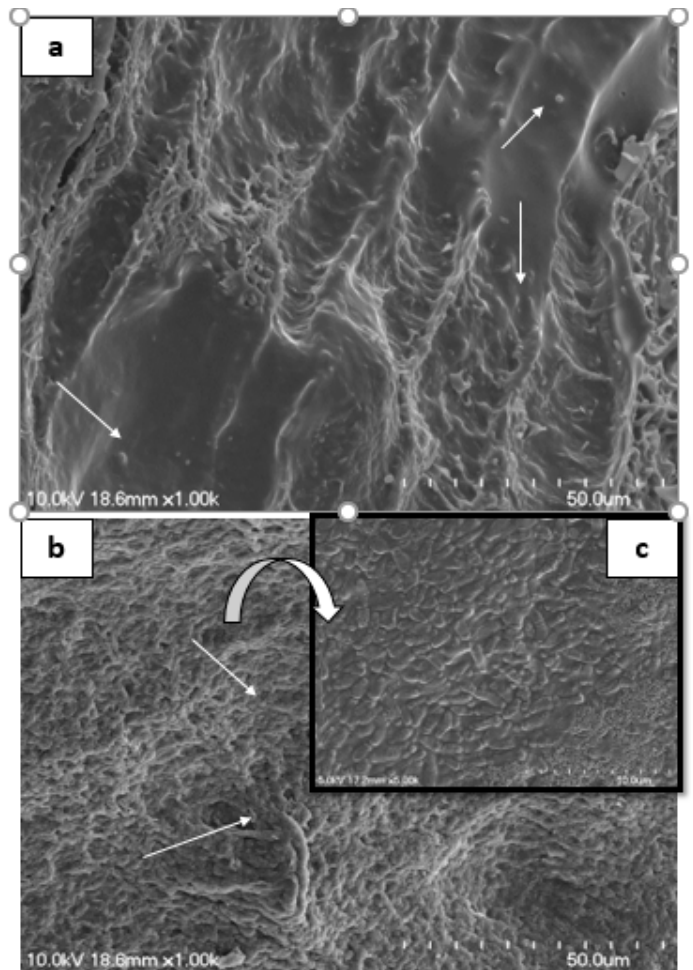
Figure 6. Scanning electron microscopy (SEM) of excised rat GIT showing presence of large number of coccus-shaped bacteria on the upper surface (G 0 ) ( a ). The rat administrated with B. longum B-11 displayed huge number of rods on the microvilli of GIT (G 1 ) ( b ). Magnified images of B. longum B-11 showing bacterial cell are V or Y shaped rods ( c ).